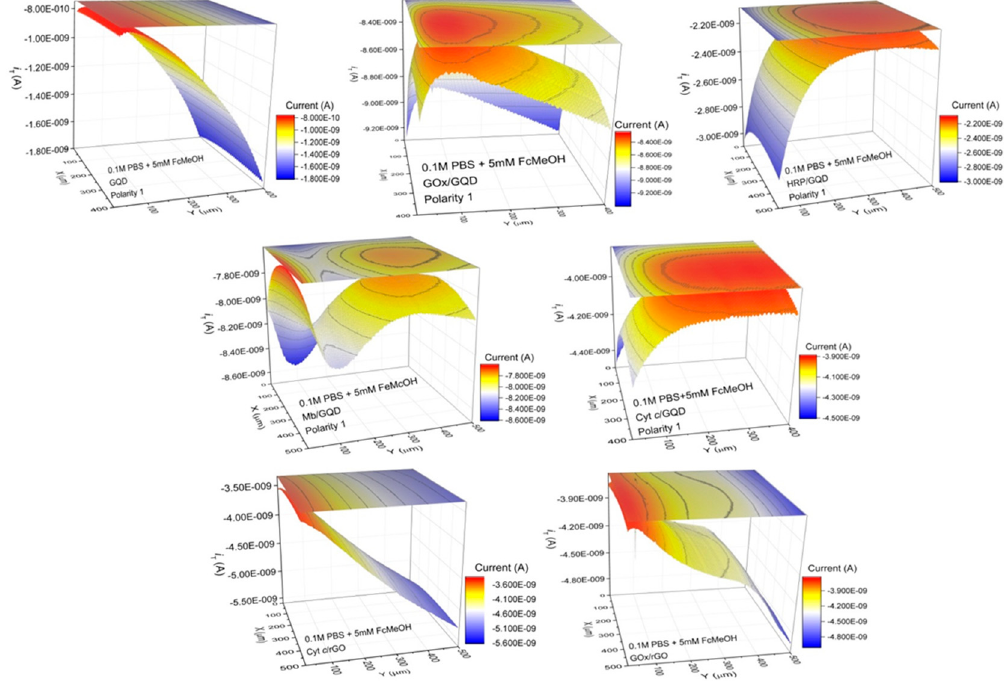
Figure 8. Scanning electrochemical microscopy (SECM) images (500 × 500 μ m 2 ) of ( a ) GQD; ( b ) GO x -GQD; ( c ) HRP-GQD; ( d ) Mb-GQD; ( e ) Cyt c -GQD; ( f ) Cyt c -GO; and ( g ) GO x -rGO samples displaying